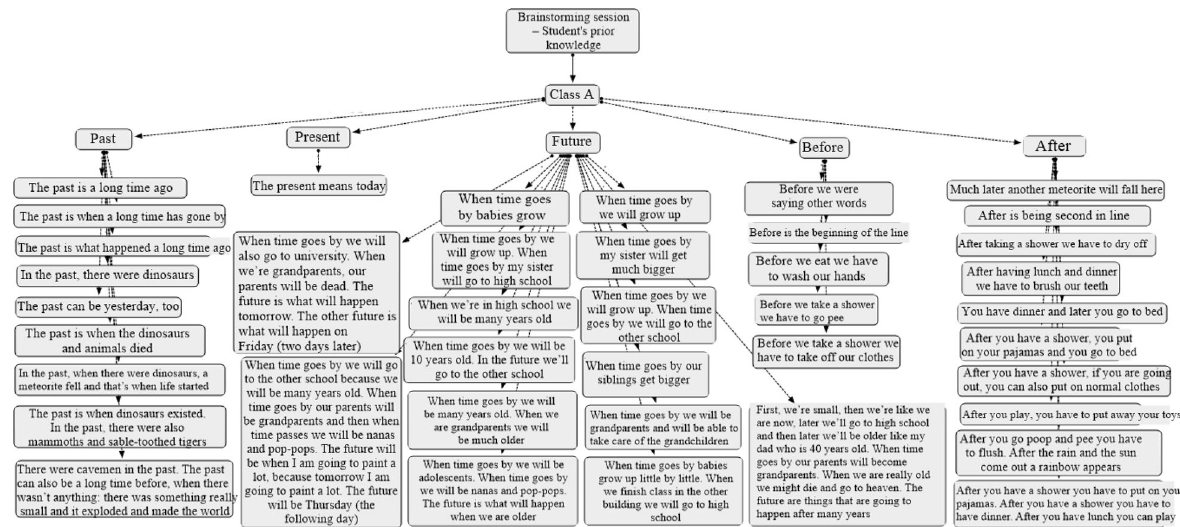
Fig. 3 Semantic network of students ’ prior knowledge from the brainstorming session with class A. This fi gure shows a semantic network of the class A students' answers.